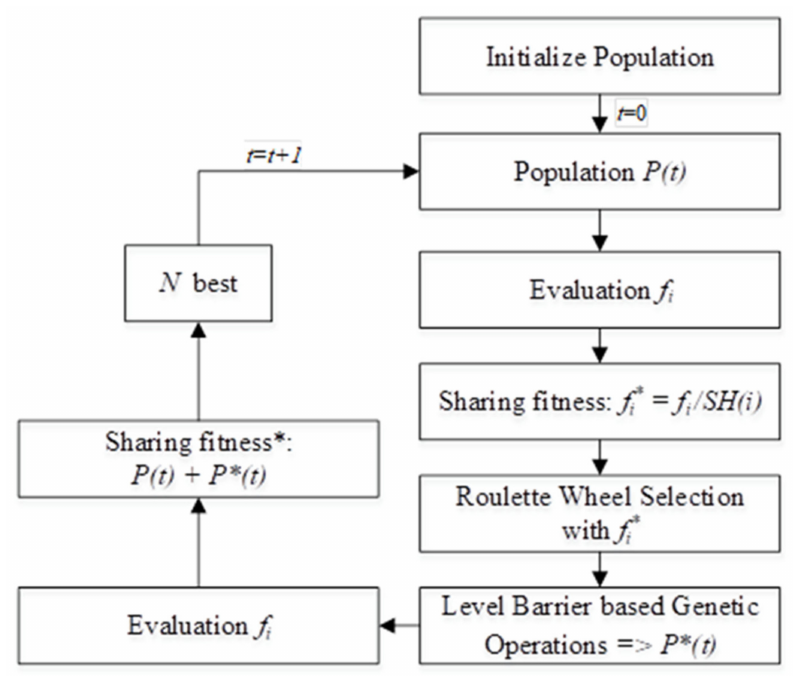
Figure 6. Sharing fitness procedure